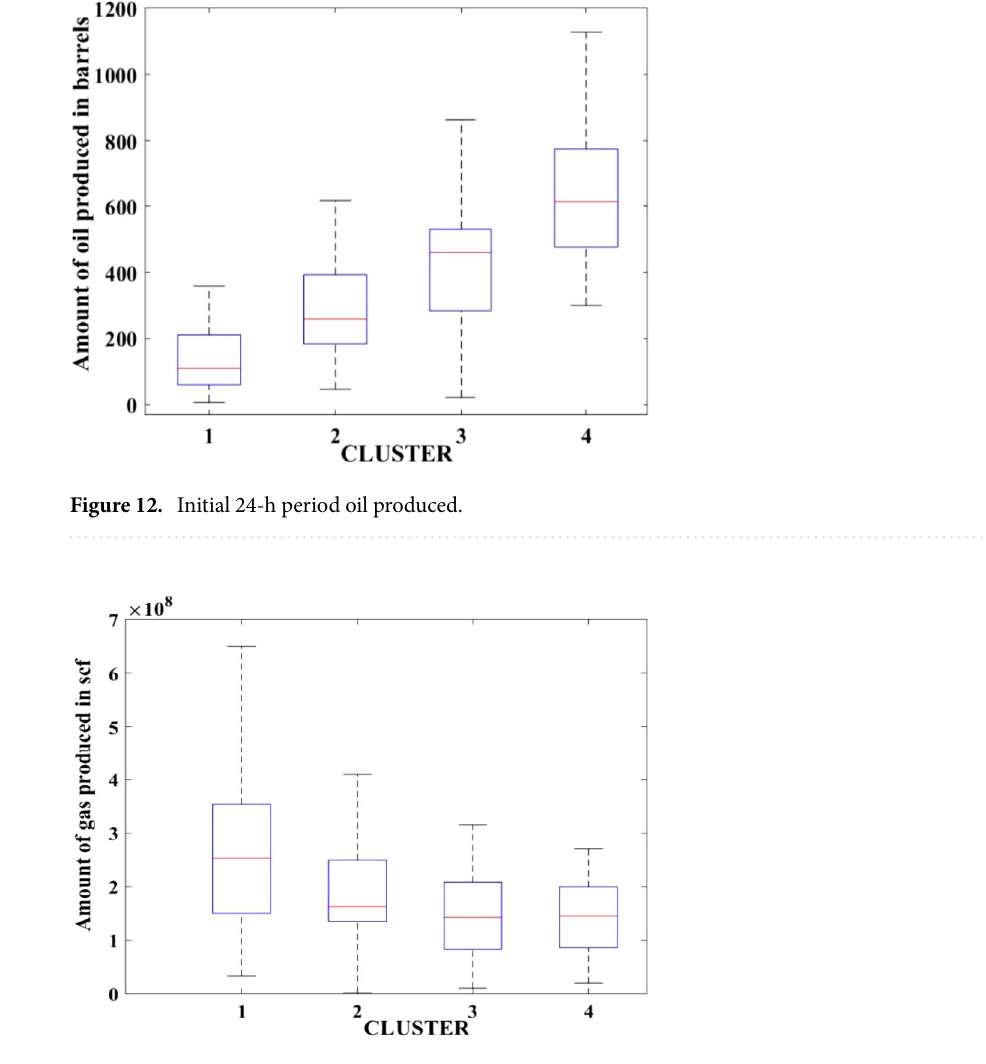
Figure 13. Initial 24-h period gas